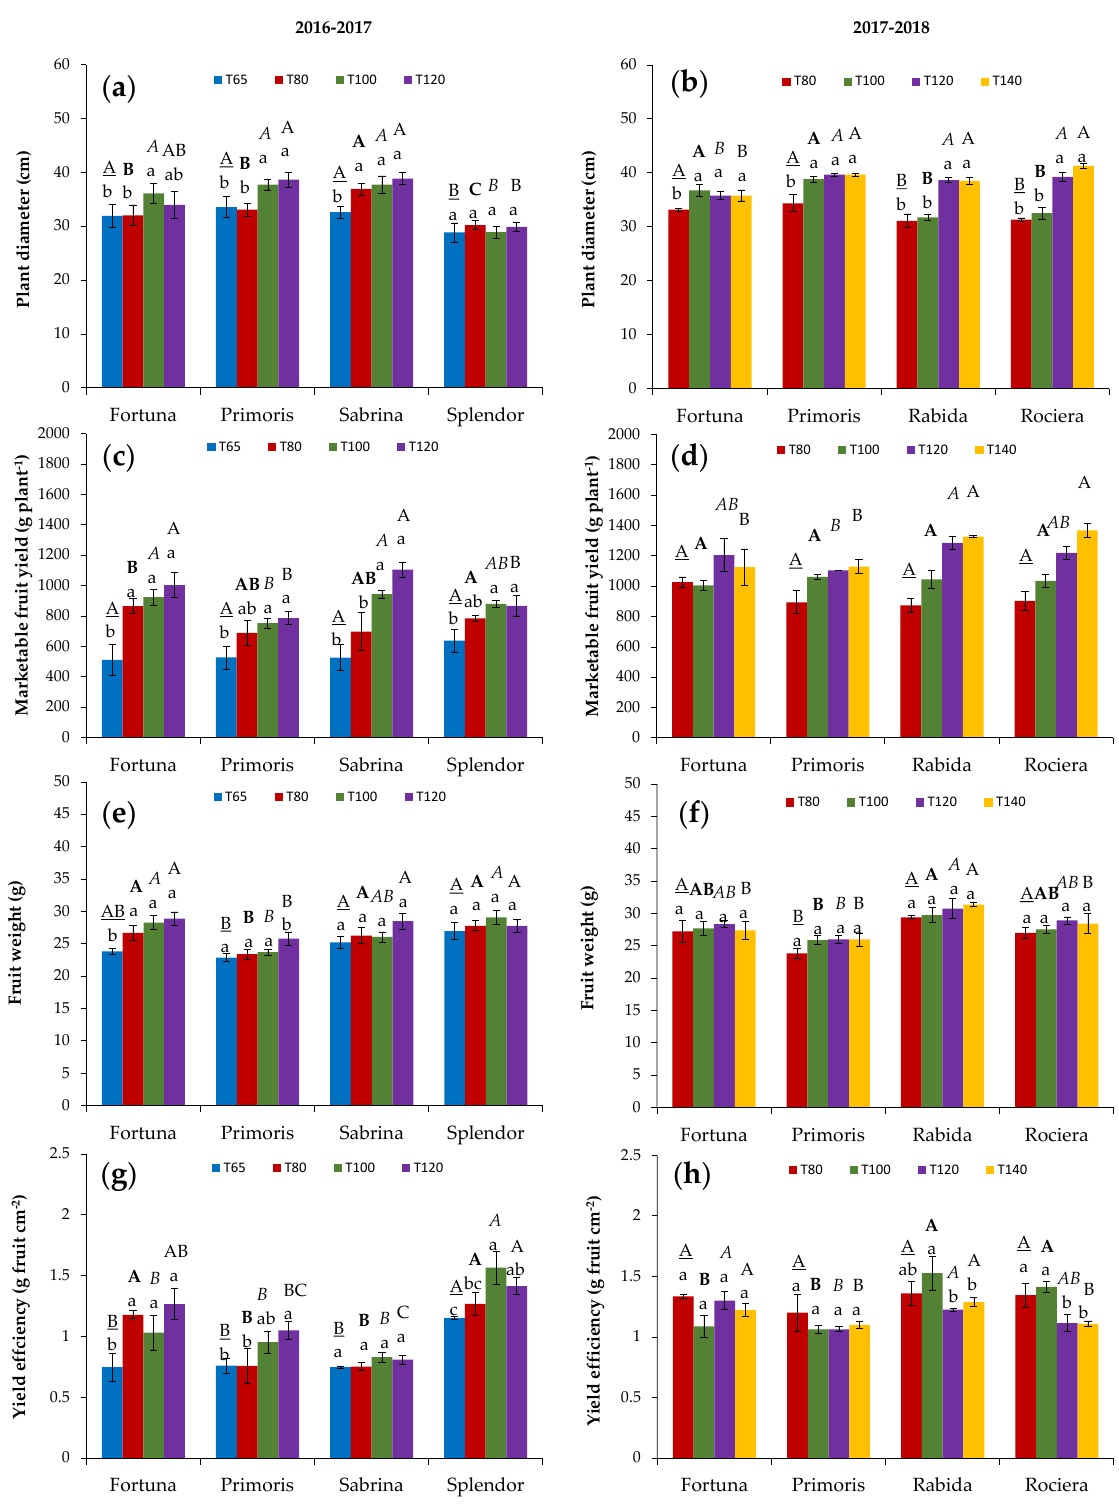
Figure 6. Mean values ( ± SE; n = 3 plots) of ( a , b ) plant diameter; ( c , d ) first class marketable fruit yield; ( e , f ) fruit weight and ( g – h ) yield efficiency of the study cultivars under the different water treatments supplied in the 2016–2017 and 2017–2018 cropping seasons. Within a cultivar, different lower case letters indicate significant ( p < 0.05) differences between water treatments, and, within a water treatment, upper case letters indicate significant differences among cultivars.